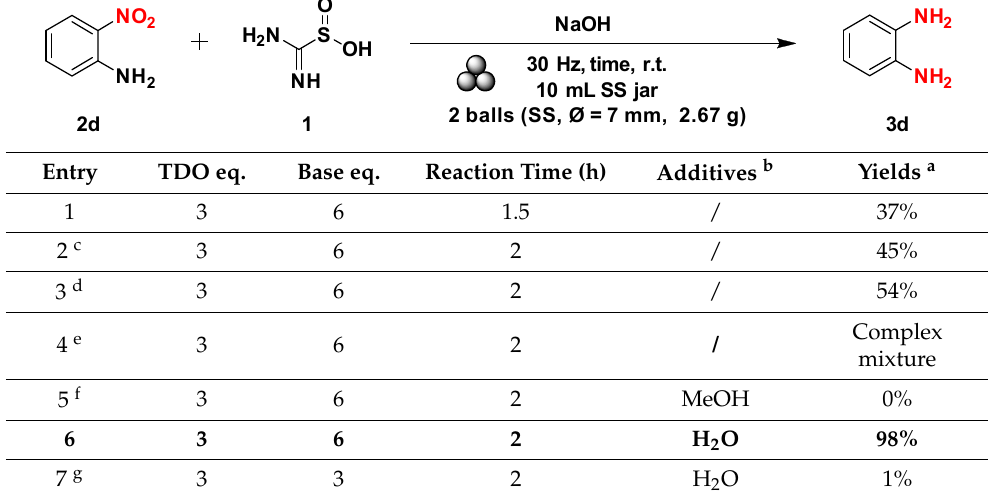
Table 2. Optimization process for the reduction of 2d to 3d .